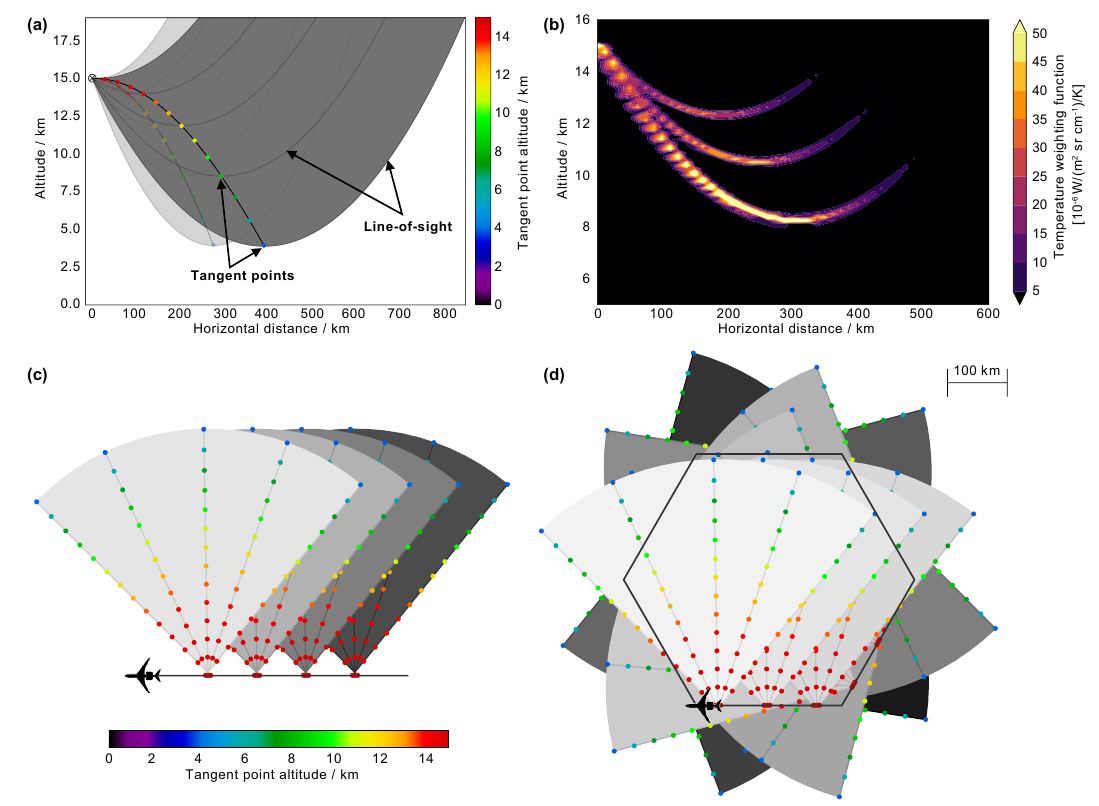
Figure 2. In panel (a) a simple schematic of the limb-sounding geometry is given. The airplane is flying into the paper plane. Images taken under 90 ◦ azimuth cover the dark grey area with the LOS. The respective tangent points (bright coloured dots) increase in distance with decreasing altitude. The tangent points of forward- and rearward-looking images (light grey and pale coloured dots) are closer to the flight path. The LOS, which is a straight line in reality, has a parabolic shape in this plot due to the transformation into a Cartesian coordinate system with the x axis following the Earth surface. Panel (b) shows the weighting function along three different LOSs, indicating the contribution of the respective part of the atmosphere to the observed signal. In panels (c) and (d) the principles of limited angle tomography (LAT) and full angle tomography (FAT) with the GLORIA instrument are depicted, respectively. Shown are top views in bird perspective of the flight path. The dots again indicate the tangent points and are coloured according to their altitude. Each grey sector indicates one horizontal scan from 45 to 135 ◦ . The lighter the grey, the later in time the measurements are that are